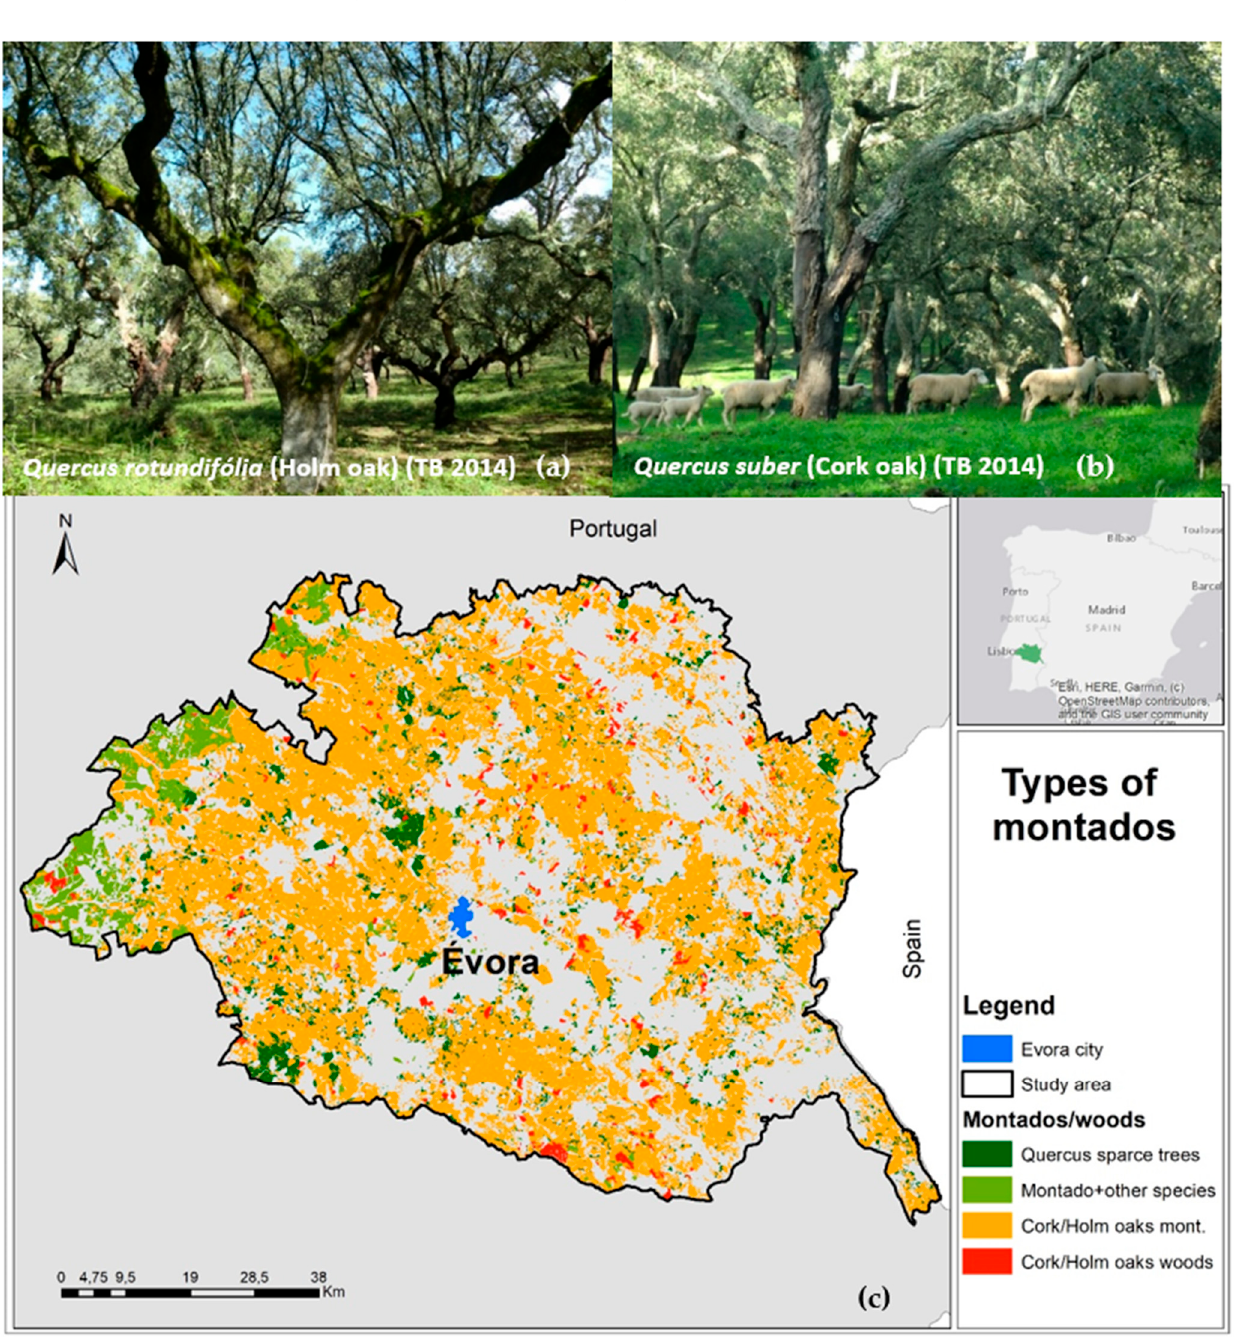
Figure 1. Study area and types of montados in Alentejo Central (author of photos ( a ) and ( b ) and map ( c ): T. Batista).